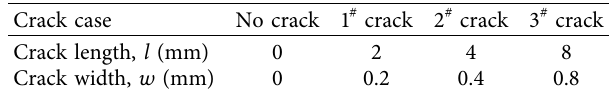
Figure 3: Tooth root crack model of sun gear. Table 2: Crack parameters of sun